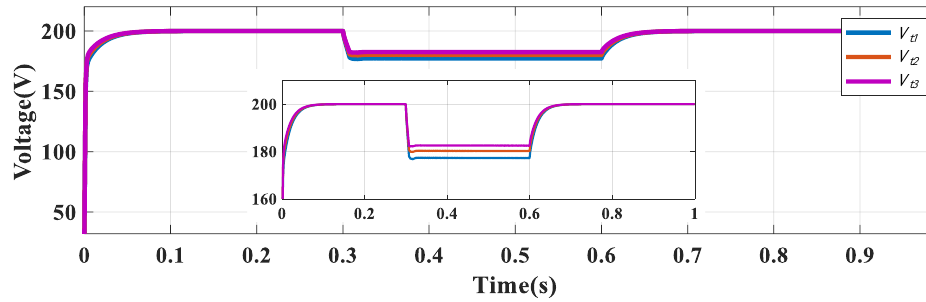
Figure 26. Study 4: output voltage of each DG.